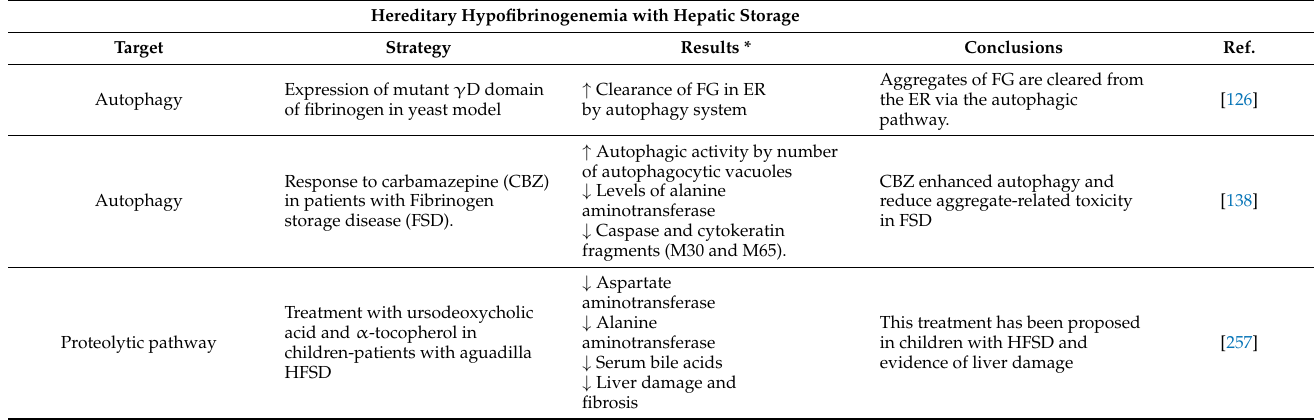
Table 4. Targets for clinical strategies against FG in